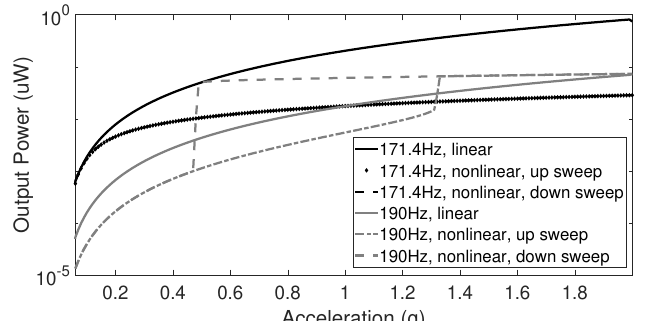
Figure 5. Amplitude–response curves for the linear and nonlinear transducer under amplitude up and down